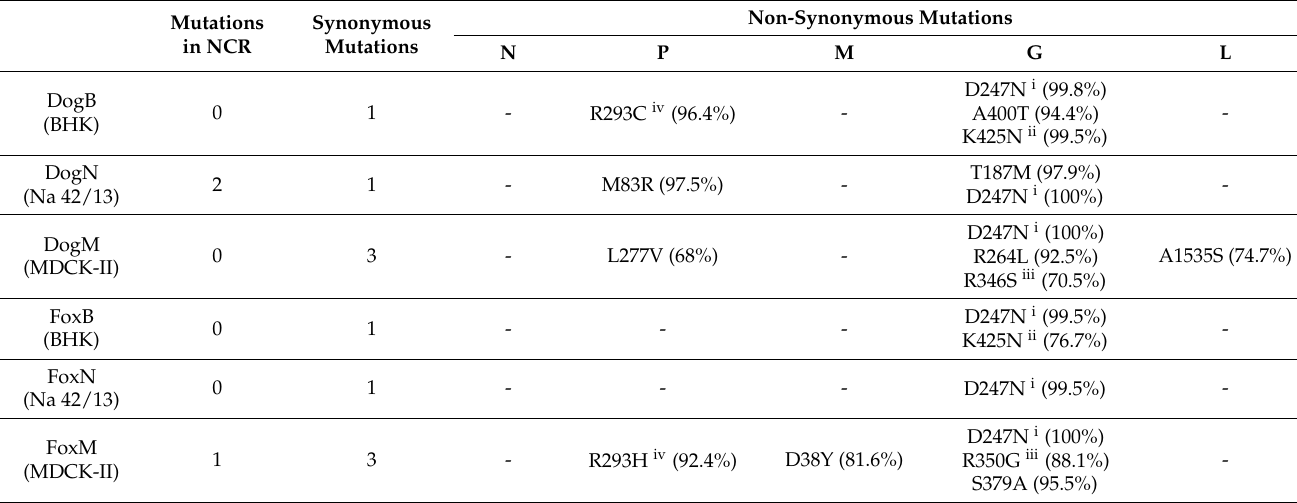
i : mutation in all sequenced P10 viruses. ii : BHK cell-specific mutation in rRABV DogB-P10 and rRABV FoxB-P10. iii : mutation in rRABV DogM-P10 and rRABV FoxM-P10 presumably representing MDCK-II cell-specific adaptations. iv : mutation in rRABV DogB-P10